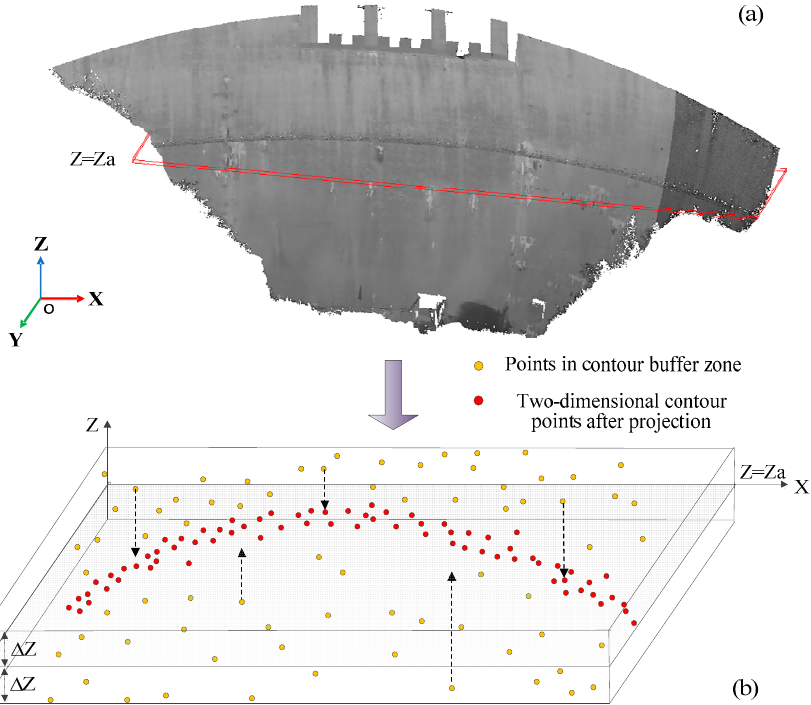
Figure 2. Contour point cloud extraction. ( a ) Extracting point cloud buffer and ( b ) extracting contour point cloud.